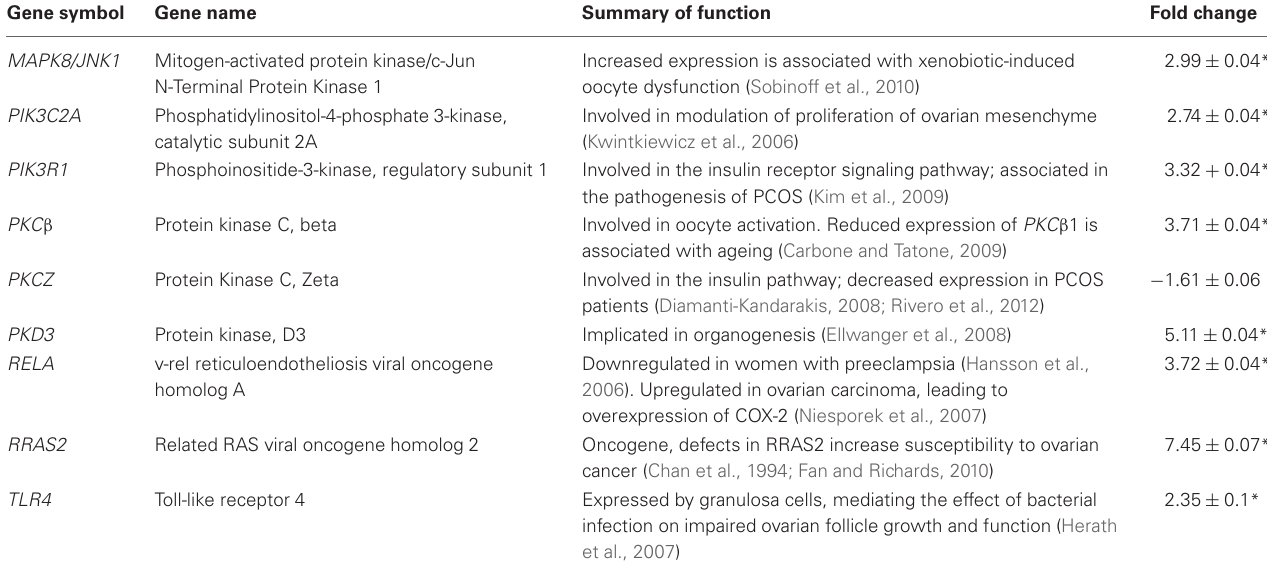
Table 2 | qRT-PCR confirmation of microarray results for the components of LPS-stimulated MAPK signaling pathway, upregulated in the ovaries of LPS-treated animals.